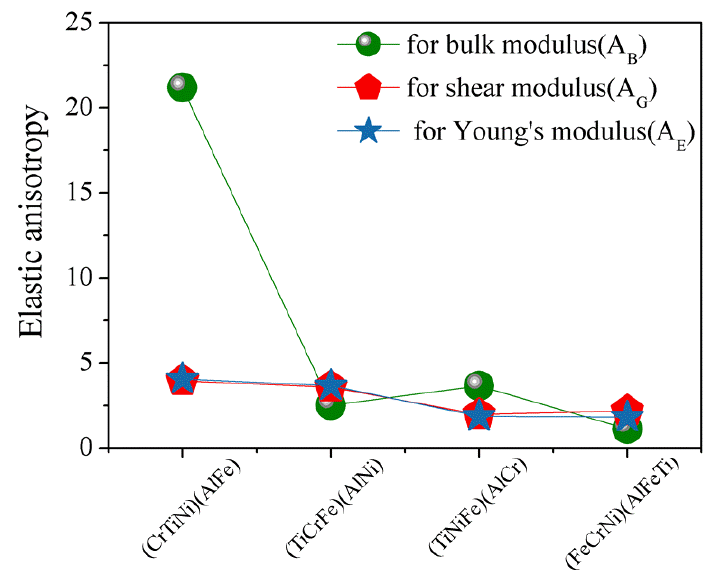
Figure 5. The calculated results of the percentage of anisotropy in bulk, shear, and young’s modulus for single-phase AlCrTiFeNi of different atom occupancy positions.